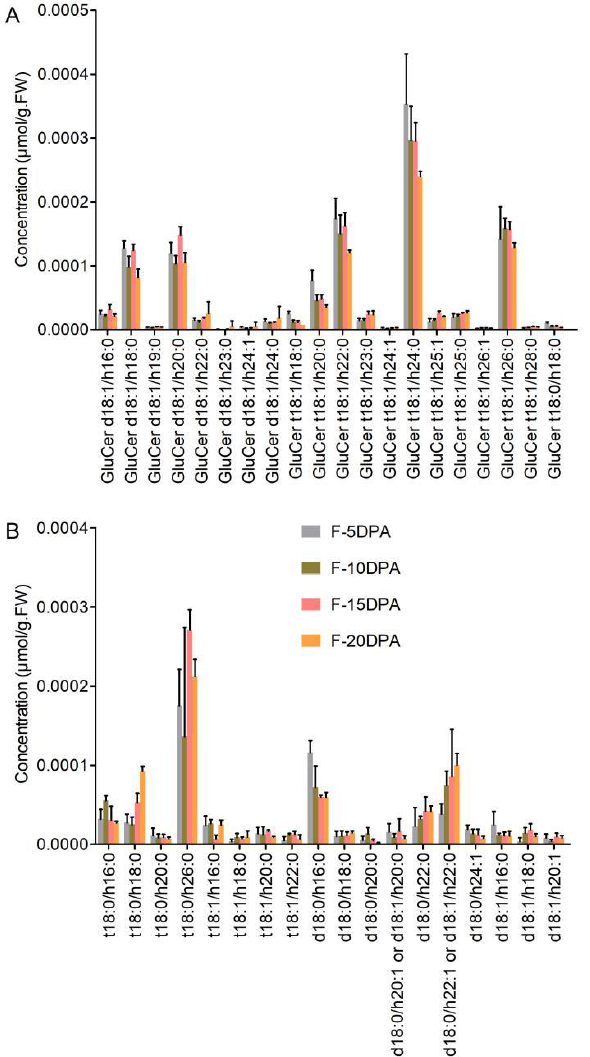
Figure 3. The concentration of complex sphingolipids in cotton fiber cells at four developmental stages. ( A ) The concentration of various molecular species of GluCer. ( B ) The concentration of various molecular species of GIPC in cotton fiber cells at four developmental stages. GluCer, gluco- sylceramides. “d18:0/1” indicates that the long-chain bases (LCB) of sphingolipids had 2 hydroxyl groups (d), 18 carbon atoms and no or 1 double bond; “t18:0/1” indicates that the LCB had 3 hydroxyl groups (t), 18 carbon atoms, and no or 1 double bond; “16-26:0/1” indicates that the long-chain fatty acid (LCFA) of sphingolipids had 16 to 26 carbon atoms and no or 1 double bond; and “h16-26:0/1” indicates that the long-chain fatty acids (LCFA) of sphingolipids were hydroxylated fatty acyls (h) and had 16 to 26 carbon atoms and no or 1 double bond. F-5 DPA, F-10 DPA, F-15 DPA, and F-20 DPA represent fiber cells at 5, 10, 15, and 20 DPA. Each analysis was repeated with three biological